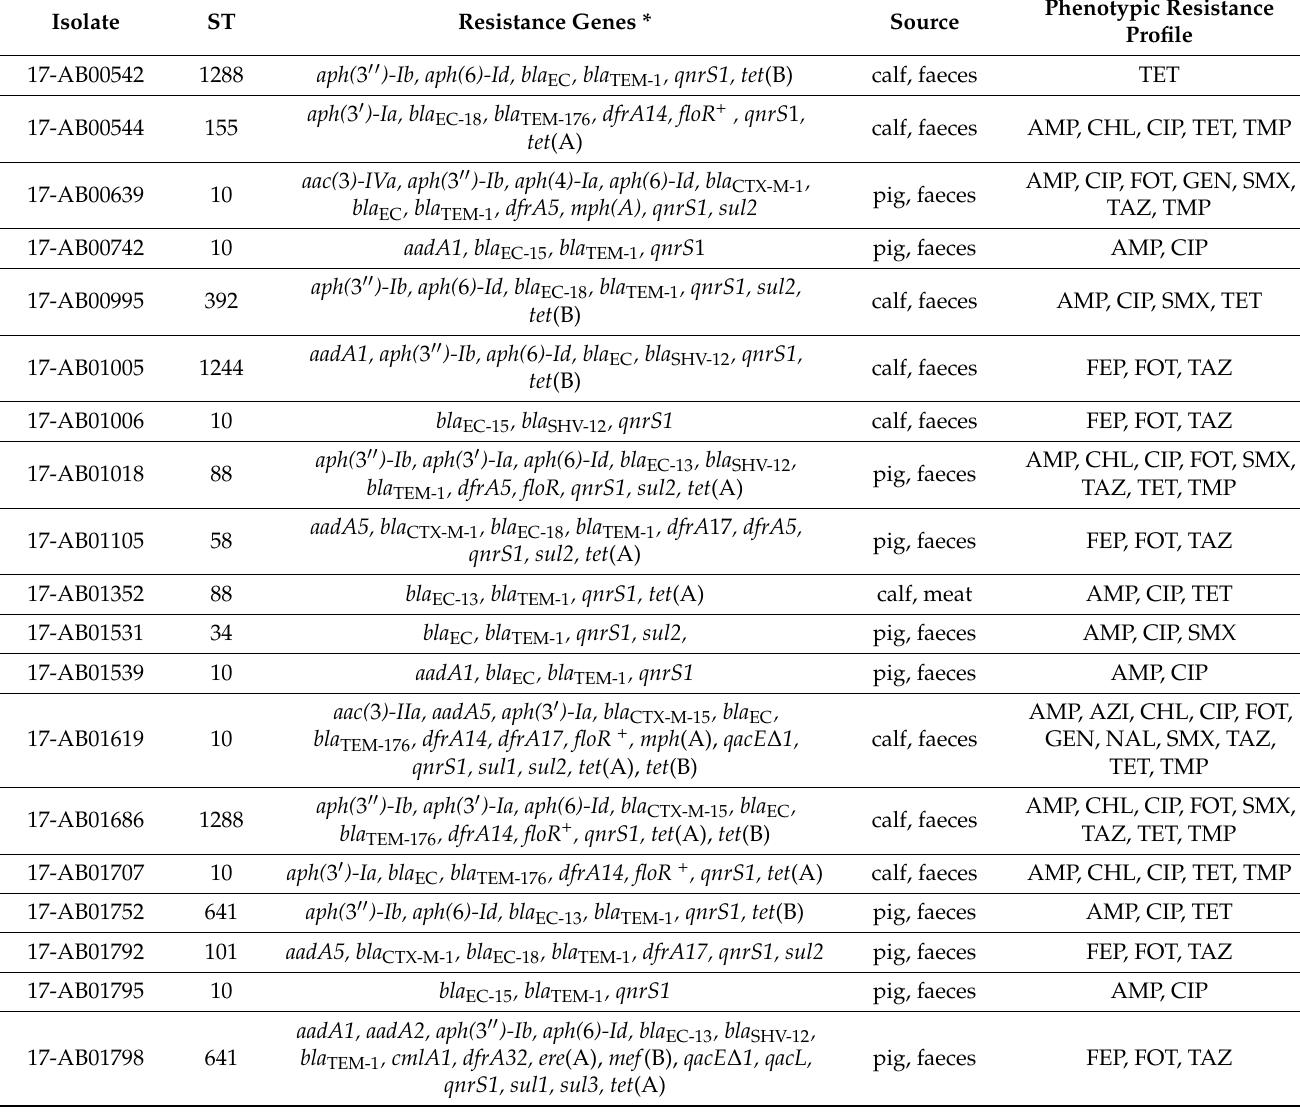
Table 1. Characteristics of E. coli carrying qnrS 1 on an IncX